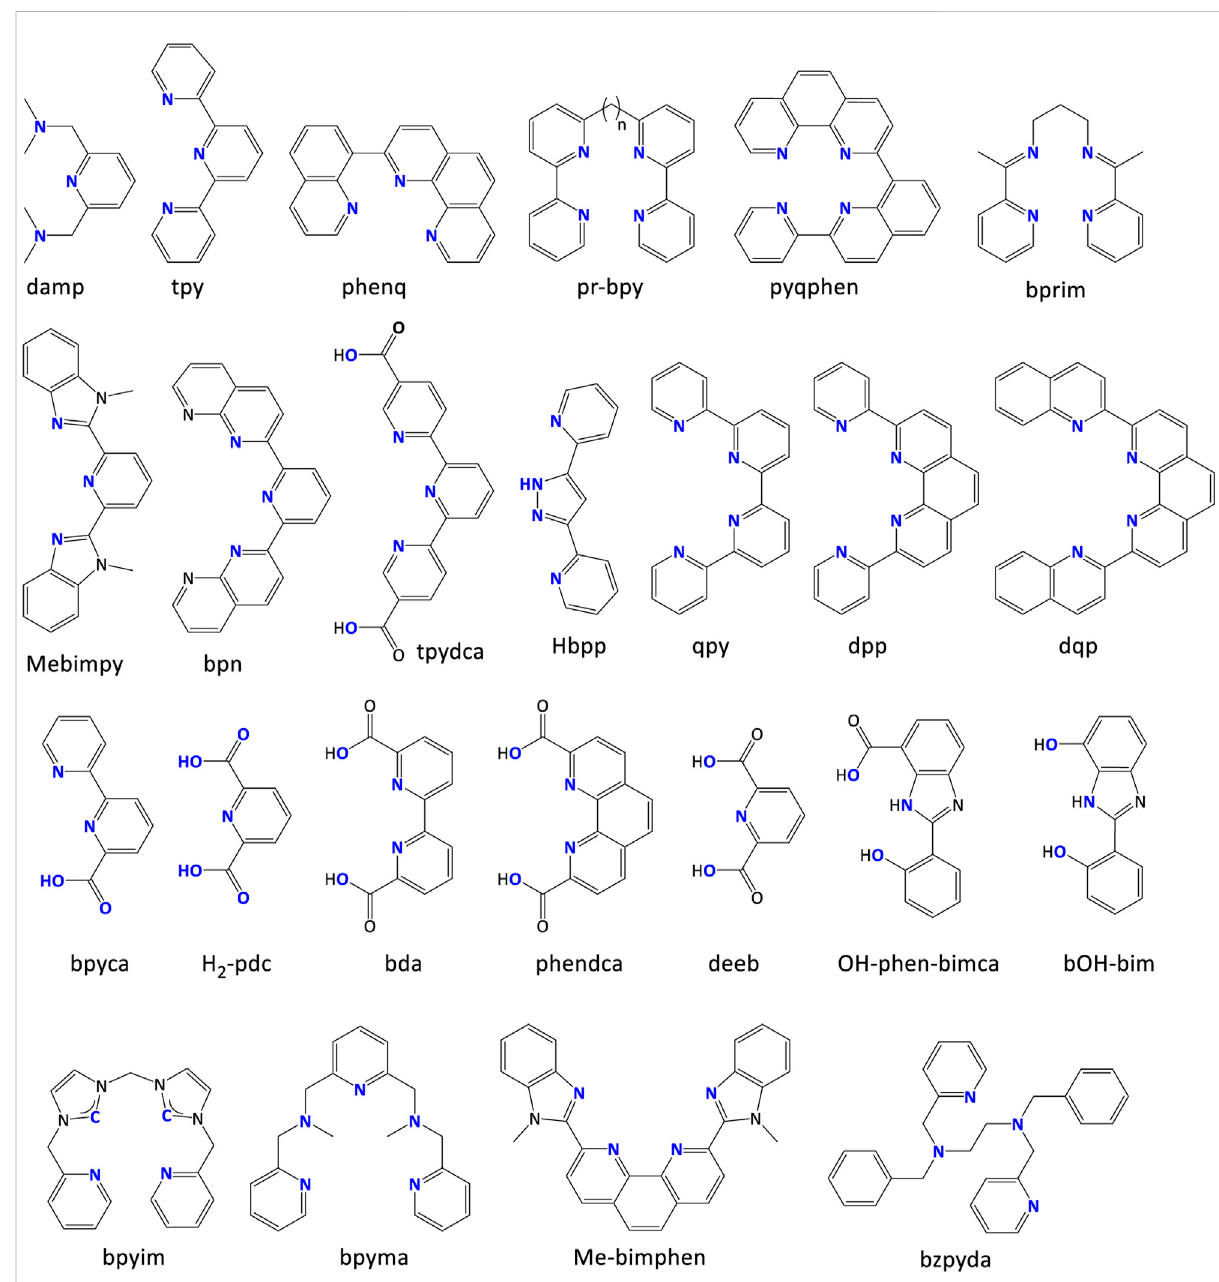
FIGURE 17 Some common multidentate ligands. Coordinating atoms are labeled in